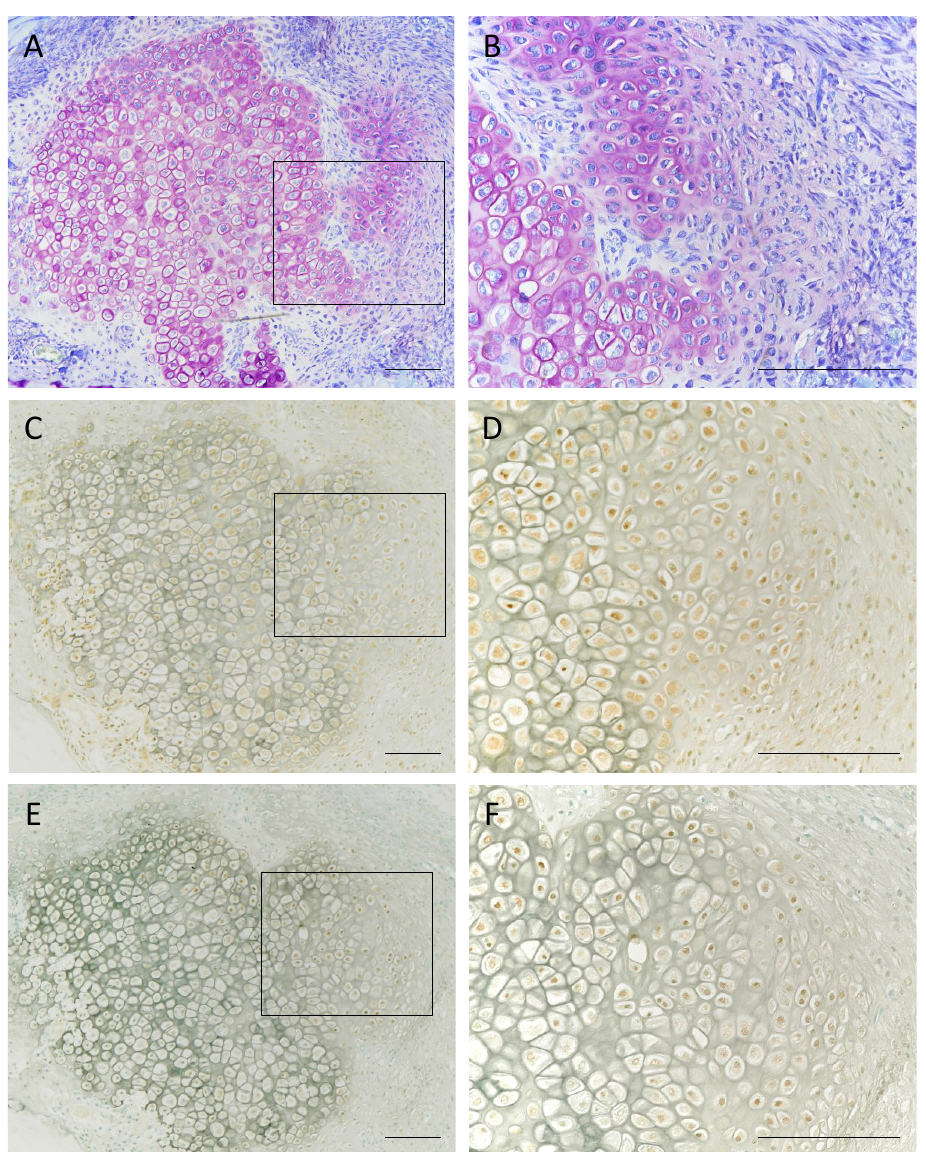
Figure 1. Histological appearance and localization of interleukin-1 β (IL-1 β ) and retinoic acid receptor gamma (RAR γ ) in fractured rat ribs at 7 days after fracturing. Sections stained with Toluidine blue ( A , B ), IL-1 β ( C , D ), and RAR γ ( E , F ) illustrate endochondral ossification at day 7 post-fracture. Each right photo showing a histological section is a magnification of the rectangle-delimited area in the corresponding left photo. Bar, 100 μm.